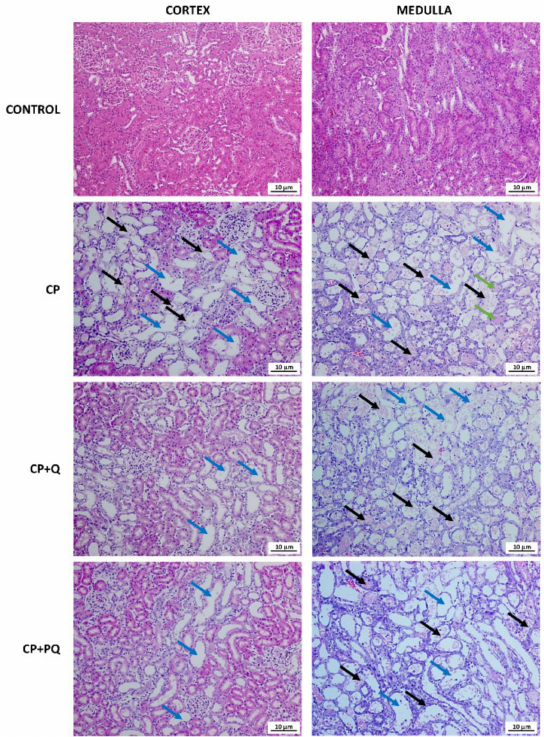
Figure 4. Representative images of renal specimens stained with hematoxylin and eosin. Black arrows: tubular necrosis and cell sloughing; blue arrows: tubular dilations; green arrows: intratubular deposits of hyaline material. CP: cisplatin (6.5 mg/kg, i.p.) on day 3; CP + Q: quercetin (50 mg/kg, i.p.) for 9 days and cisplatin (6.5 mg/kg, i.p.) on day 3; CP + PQ: P-quercetin (100 mg/kg, i.p.) for 9 days and cisplatin (6.5 mg/kg, i.p.) on day